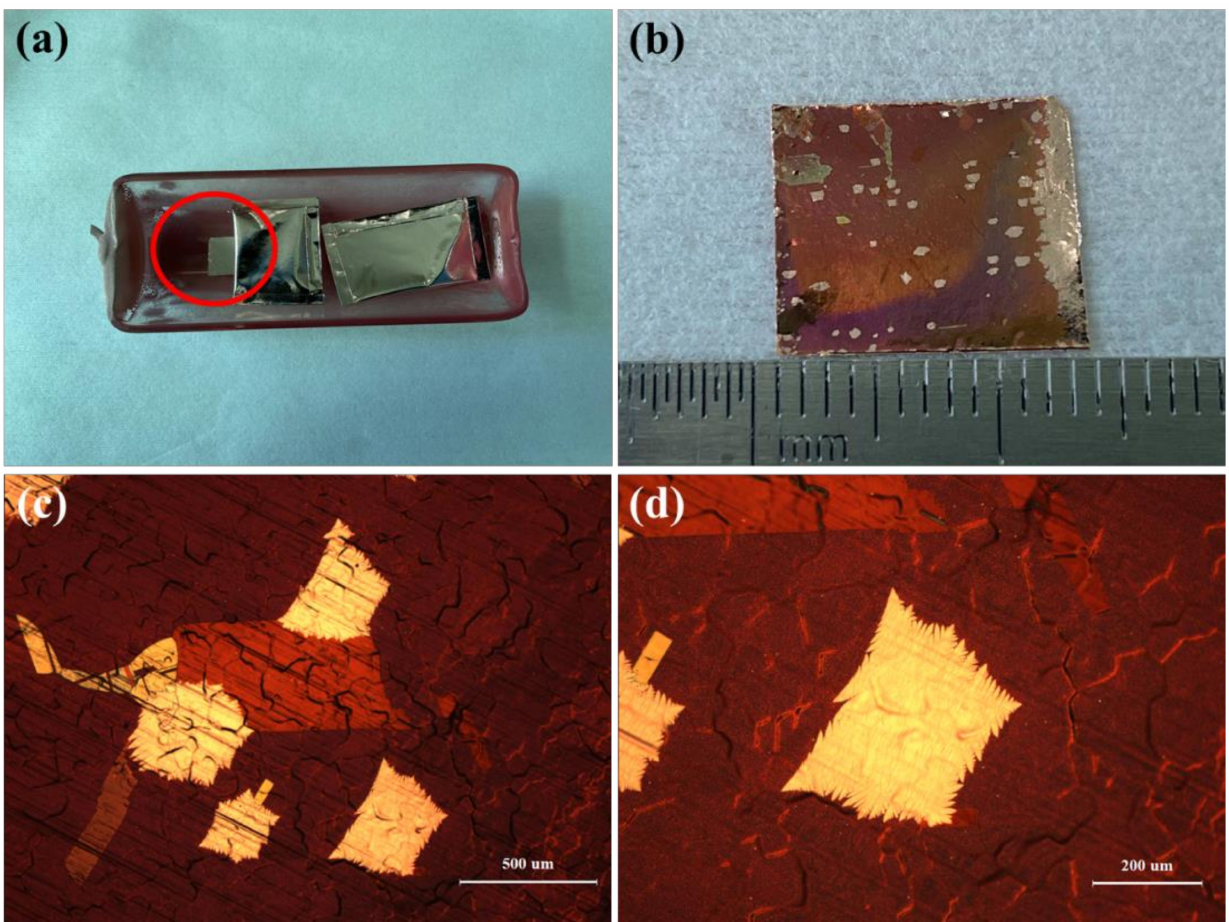
Figure 6. ( a ) Optical picture of the copper foil placed in the quartz boat in the experiment. ( b ) Optical picture of the back of the copper foil with single-crystal graphene. ( c ) Optical micrograph of single-crystal graphene on the back of the copper foil under 50-times magnification. ( d ) Optical micrograph of single-crystal graphene on the back of the copper foil under 100-times